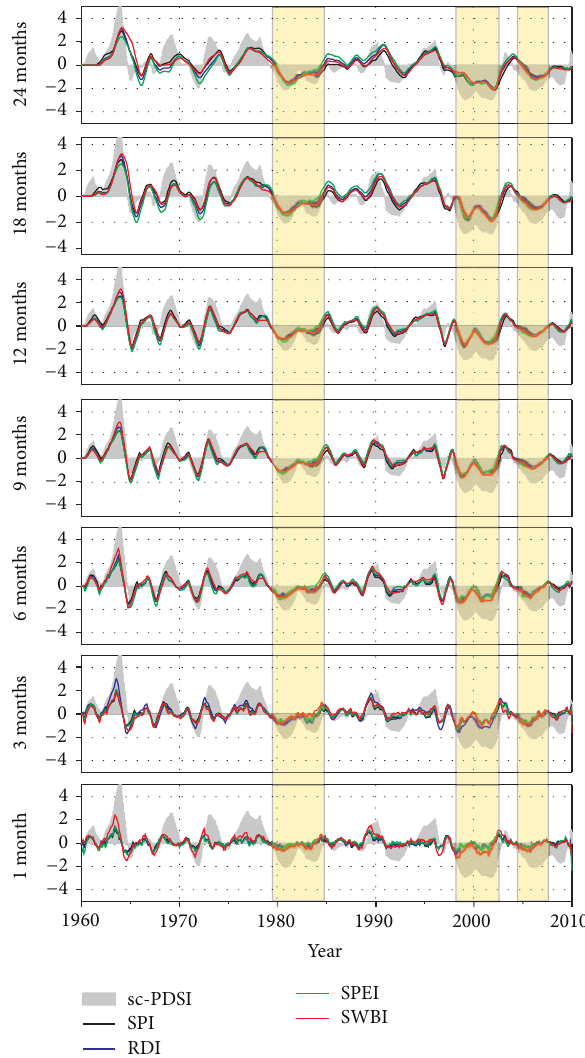
Figure 6: Comparisons of the drought indices at multiple time scales in Haihe River basin (the drought indices were smoothed by moving average filter with the span of 12 months, and three serious drought periods are marked by yellow